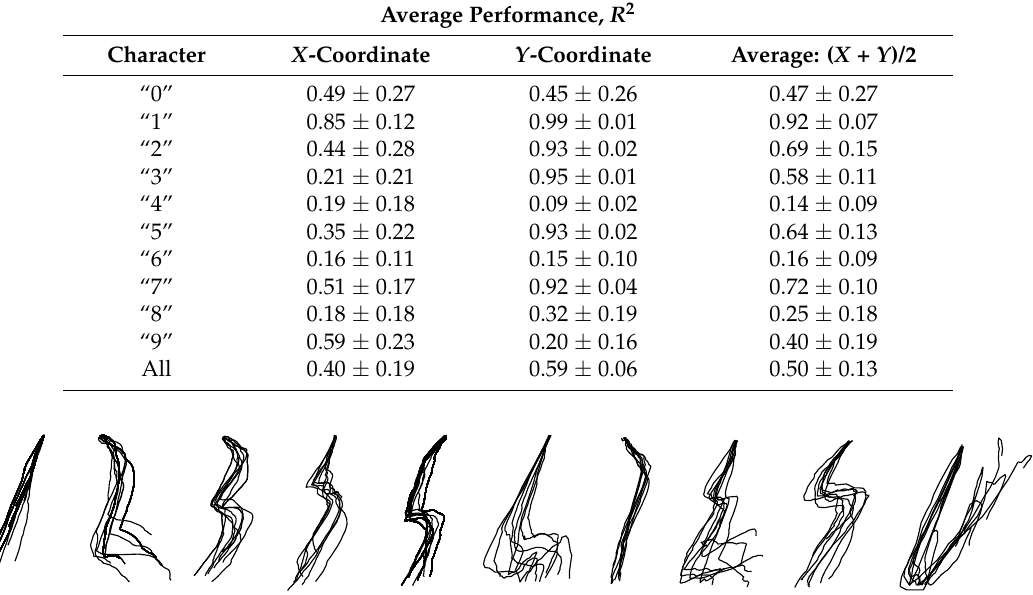
Figure 6. The randomly selected reconstructed numeric characters of with-group reconstruction by the KF-GEP.